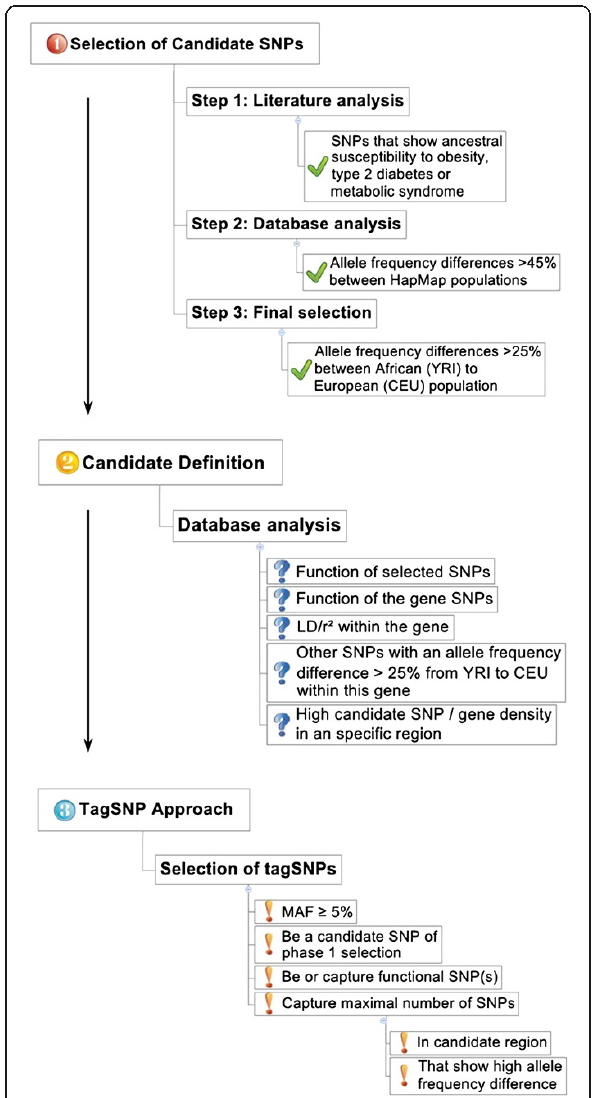
Figure 1 Workflow for the selection of candidate SNPs for the ancestral susceptibility